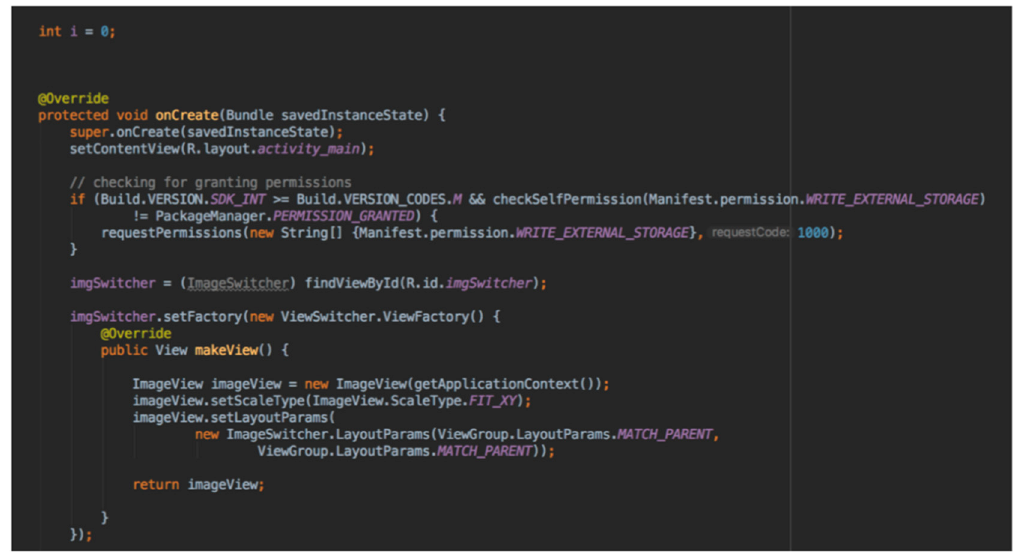
Figure 8. Java code of the prototype application.